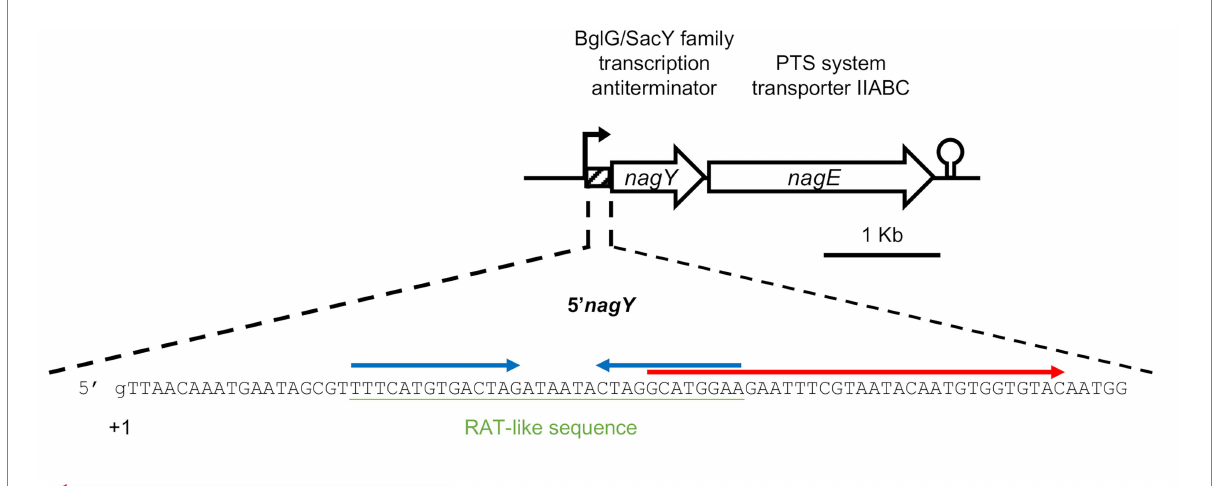
FIGURE 2 Representation of the nagY-nagE operon and 5’ nagY sequence. Transcription start (+1), ribosome binding, and translation start (in bold) sites are indicated. The sequence deleted in the Δ 5’nagY mutant is in capital letters. The RAT-like sequences are underlined in green, and the terminator and the antiterminator identified are overligned by inverted arrows in red and blue,